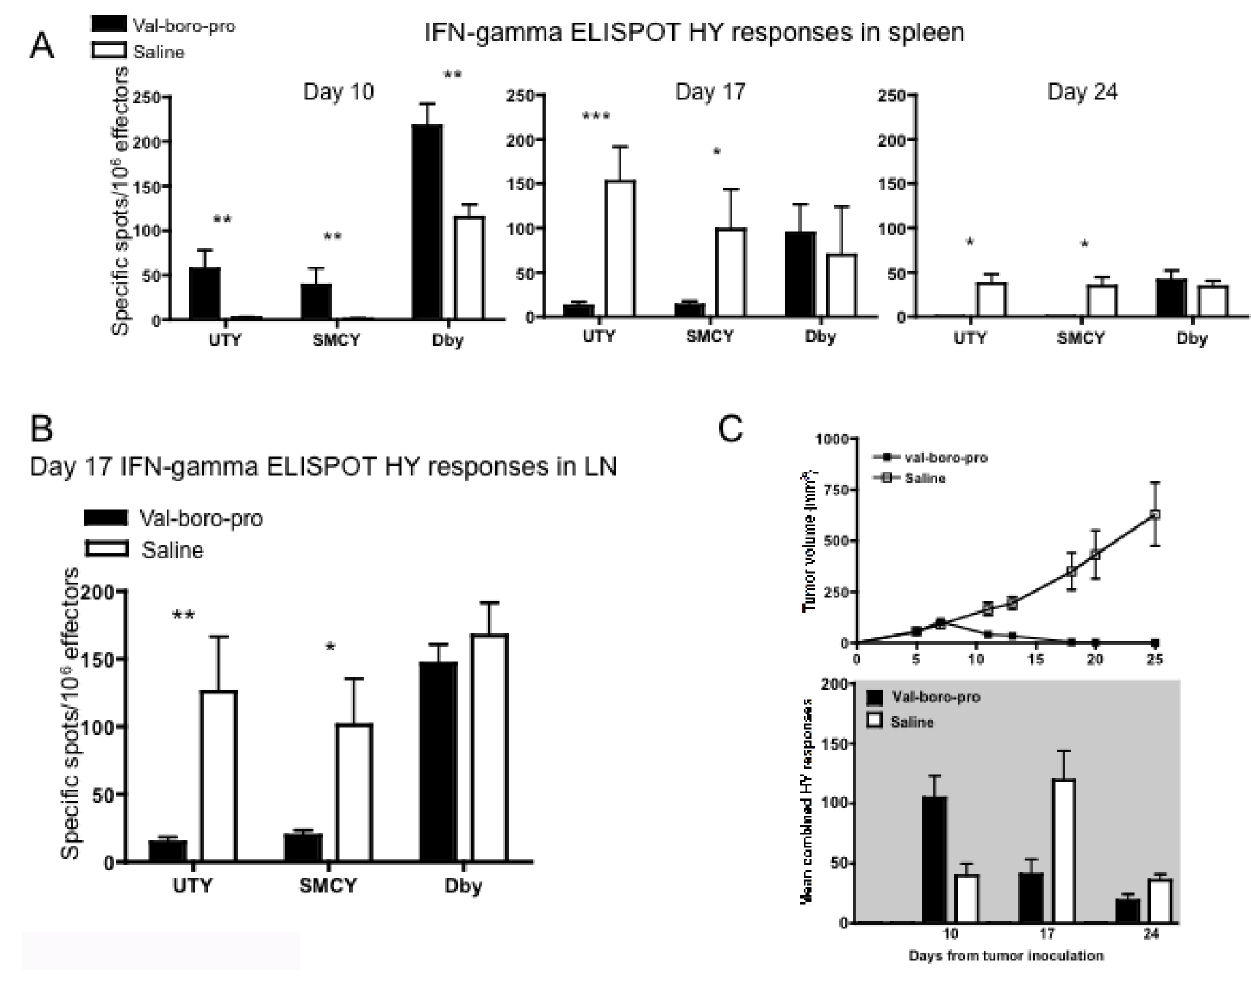
Figure 3. Val-boroPro treatment is associated with an acceleration of tumor-induced priming. (A) Female mice were inoculated with MB49 and treated with Val-boroPro (closed bars) or saline (open bars) (n=12/group). Spleens and lymph nodes were harvested from mice on days 10, 17, and 24 for IFN-gamma ELISPOT analysis (*p , 0.05, **p , 0.01, ***p , 0.001, Mann-Whitney). (B) Mice were treated as in Figure 3A. On day 17, greater numbers of HY-reactive CD8 + T cells were observed in the lymph nodes of saline-treated (open bars) mice compared to Val-boroPro treated (closed bars) mice (*p , 0.05, **p , 0.01, Mann-Whitney, n=5/group). (C) Composite data showing combined (UTY + SMCY + DBY) relative to tumor volume from mice treated in figure 1A with saline (open squares top, open bars bottom) or Val-boroPro (closed squares top, closed bars bottom) (n=12/group). Figures 3A–C are representative of 3 experiments.